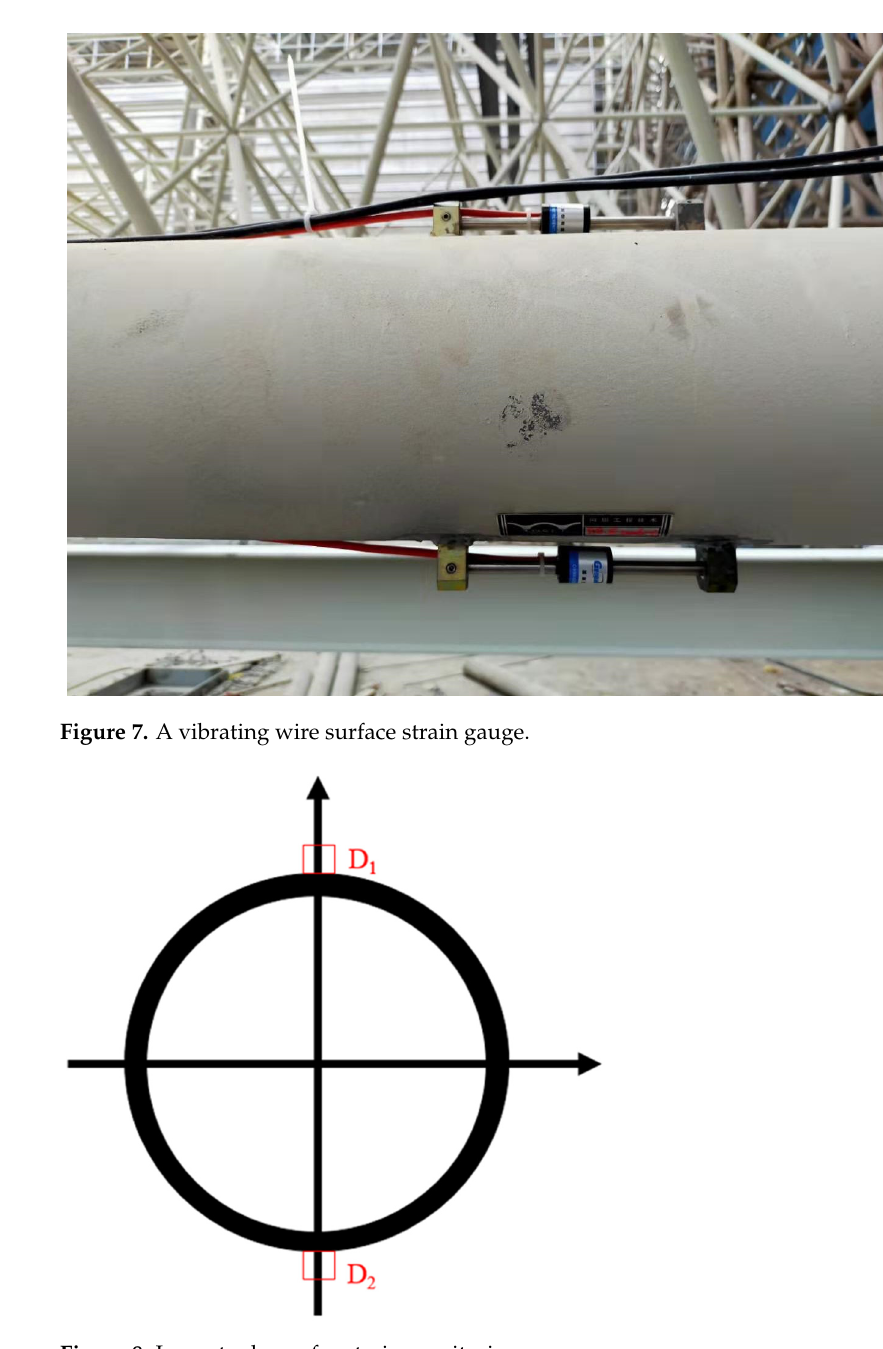
Figure 8. Layout scheme for strain monitoring.